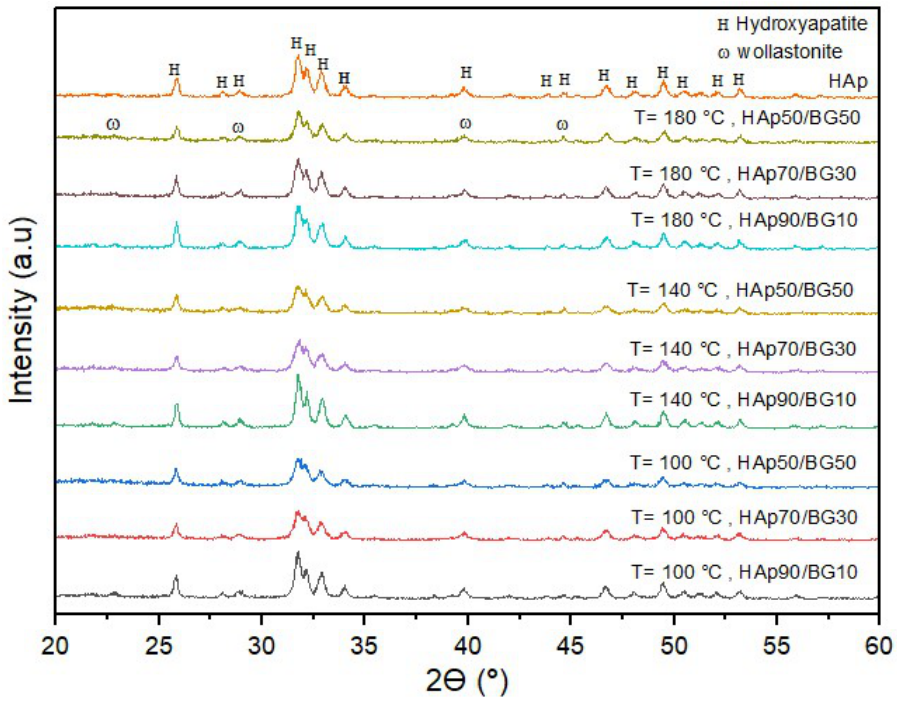
Figure 3. XRD patterns for HAp/BG composites in different conditions based on DOE. Table 4. Crystallinity and crystal size of HAp/BG composites at hydrothermal process temperature 100 ◦